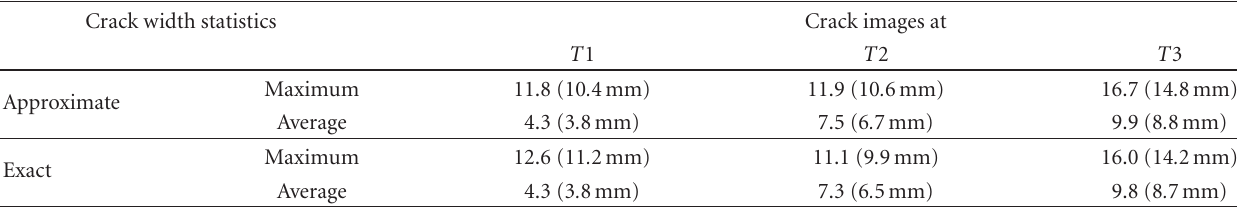
Table 2: Crack width statistics for detected cracks at di ff erent times: the top two rows are from the level set-based approximate method, and the bottom two rows are from the explicit searching method (numbers in parentheses are true values of crack width considering the image